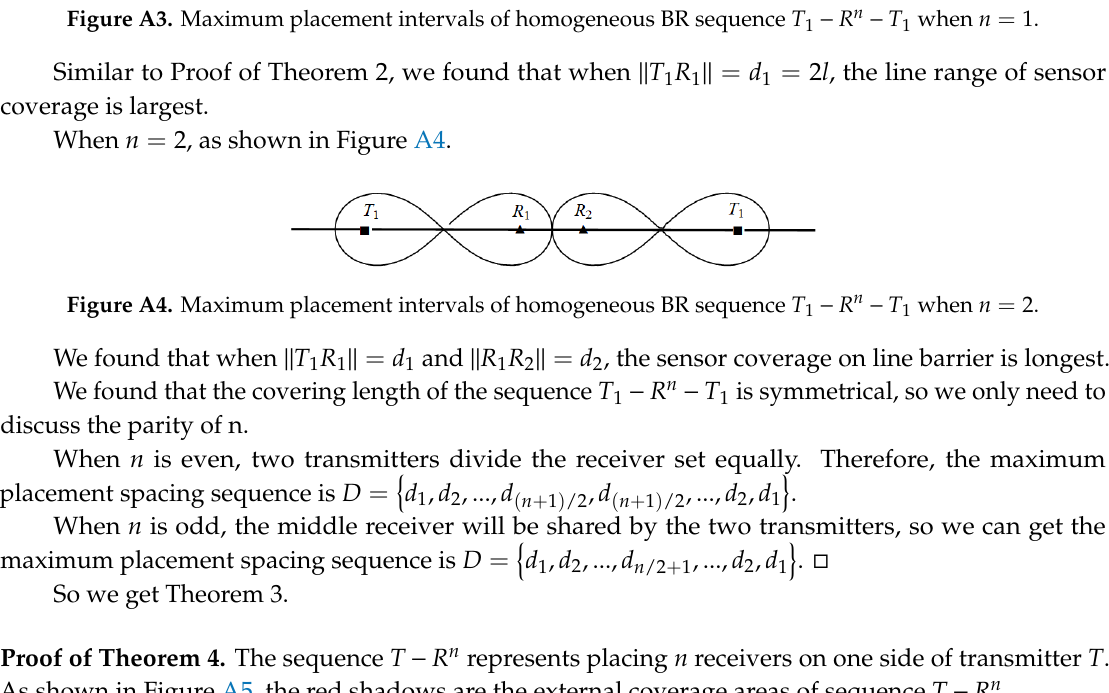
Figure A5. External coverage area of n T R  .